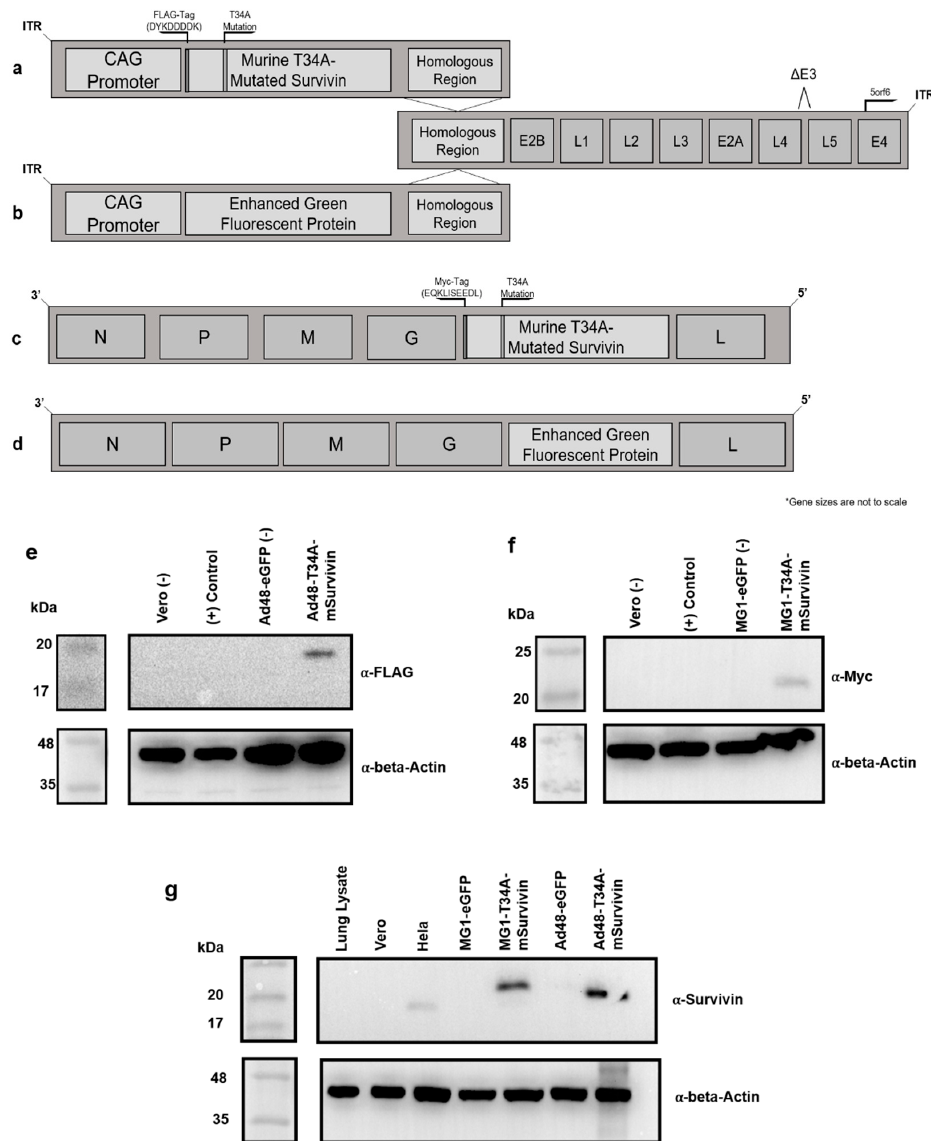
Figure 1. Schematic representation of murine survivin- and enhanced green fluorescent protein (eGFP)-expressing virus vectors, with Western blots showing expression of survivin after infecting cells. ( a ) The adenoviral survivin adaptor region for Ad48-T34A-mSurvivin expressed the mutated survivin transgene under a CAG promoter, which was FLAG-tagged for ease of determining expression levels and distinguishing the transgene from endogenous survivin. This was recombined with the adenoviral genome at the homologous region noted in place of the E1 protein. ( b ) Similarly, an eGFP-expressing adaptor region of the Ad48-eGFP virus recombined with the homologous region of the adenoviral genome. ( c ) The Maraba virus mutated-survivin vector MG1-T34A-mSurvivin had a Myc tag and was expressed between the G and L proteins of the Maraba virus genome. ( d ) The VSV-eGFP vector was generated by cloning the eGFP between the G and L proteins of the Indiana strain of wild-type VSV. SDS-PAGE Western blots of survivin-expressing vectors were generated using infected cell lysates. ( e ) Vero cells were infected with recombinant Ad48 vectors for 24 h. Uninfected Vero cell-derived lysate was used as a control. All lanes were loaded with 15 μ g of lysate and probed with a FLAG tag-specific antibody. ( f ) Lysate from Vero cells 24 h post-infection with recombinant Maraba virus. Lysate from uninfected Vero cells was used as a control. All lanes were loaded with 15 μ g of lysate and probed with an anti-Myc tag. ( g ) Vero cells infected with either Ad48 vectors, Maraba virus vectors or uninfected negative controls. All lanes were loaded with 15 μ g of lysate and probed with a survivin-specific antibody. Normal lung lysate was used as a negative control that did not express substantial amounts of endogenous survivin. The tagged murine survivin was expected to be ~5.6% larger than the endogenous survivin protein. ITR = inverted terminal repeats .